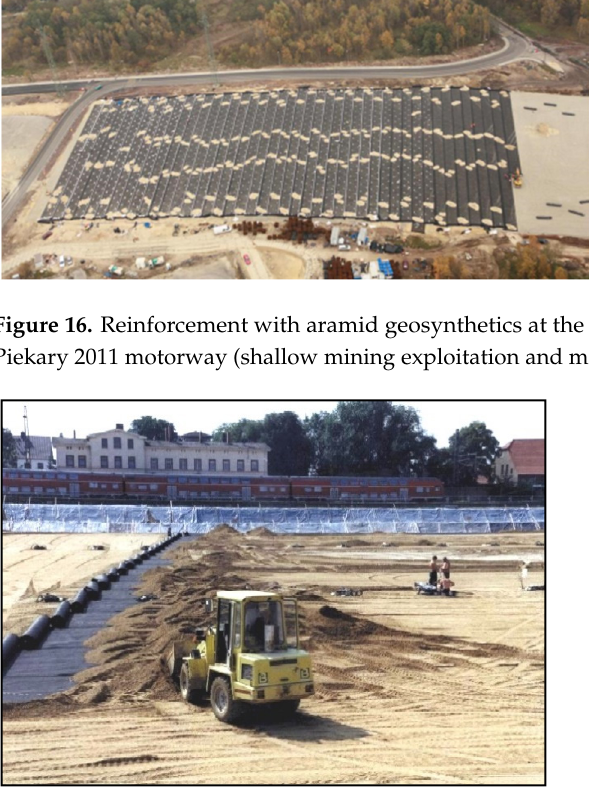
Figure 17. Reinforcement with aramid geosynthetics at the foundation level of the Gröbers junction 2001 railway embankment (sinkholes up to 4 m in diameter were